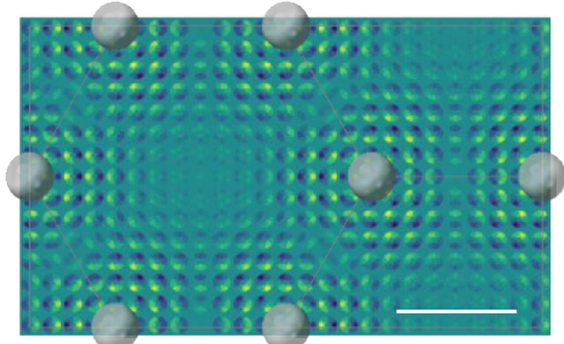
Fig. 2 The variation of simulated CBED patterns. Simulated CBED patterns as a function of probe position for 60 kV incident electrons on graphene overlayed on the atomic positions. An aberration-free probe with a probe forming aperture of 31 mrad was assumed with resulting CBED patterns having a diameter of 62 mrad. No incoherence was added at this stage. The scale bar shown is 1 Å in length.